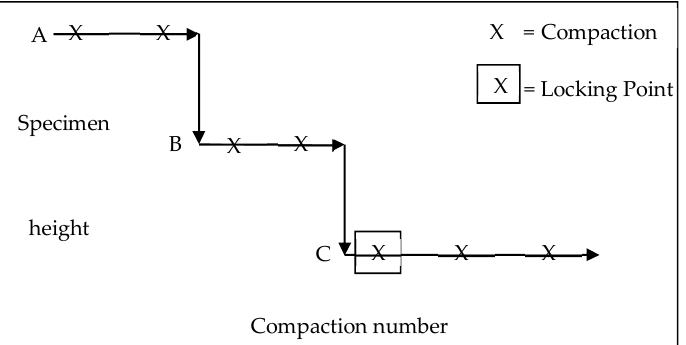
Figure 2. Schematic diagram of the locking point.